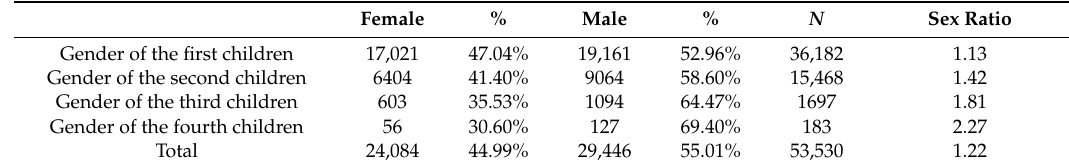
Table 3. Distribution of the sex composition of existing children.